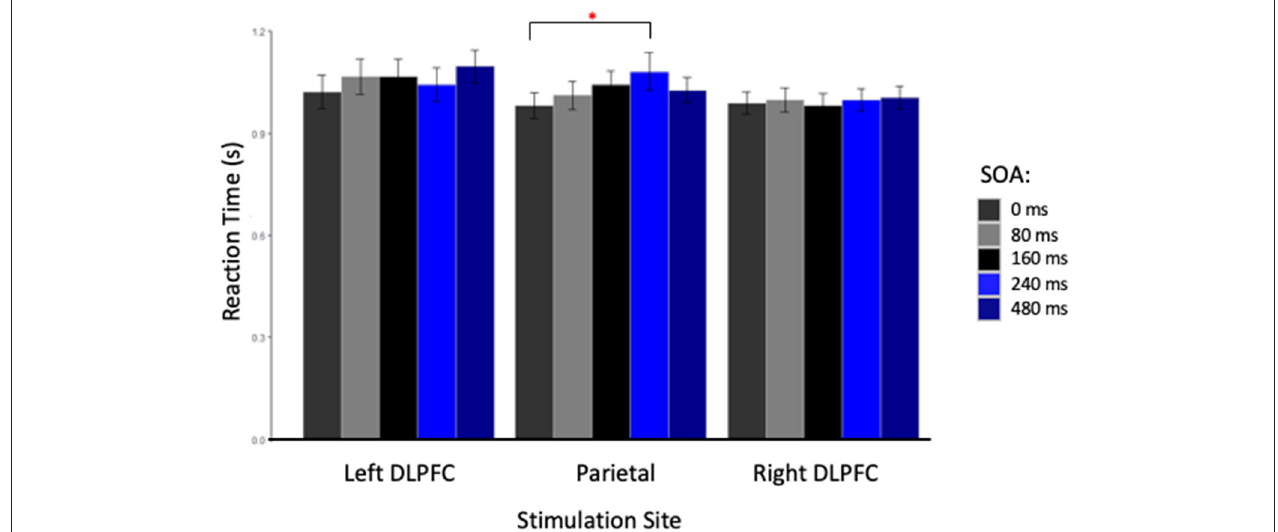
FIGURE 2 | Reaction Time in seconds for each stimulation site at each stimulus onset asynchrony (SOA). The red star indicated a significant difference between reaction times for TMS applied at 0 and 240ms, only when the parietal cortex was stimulated.